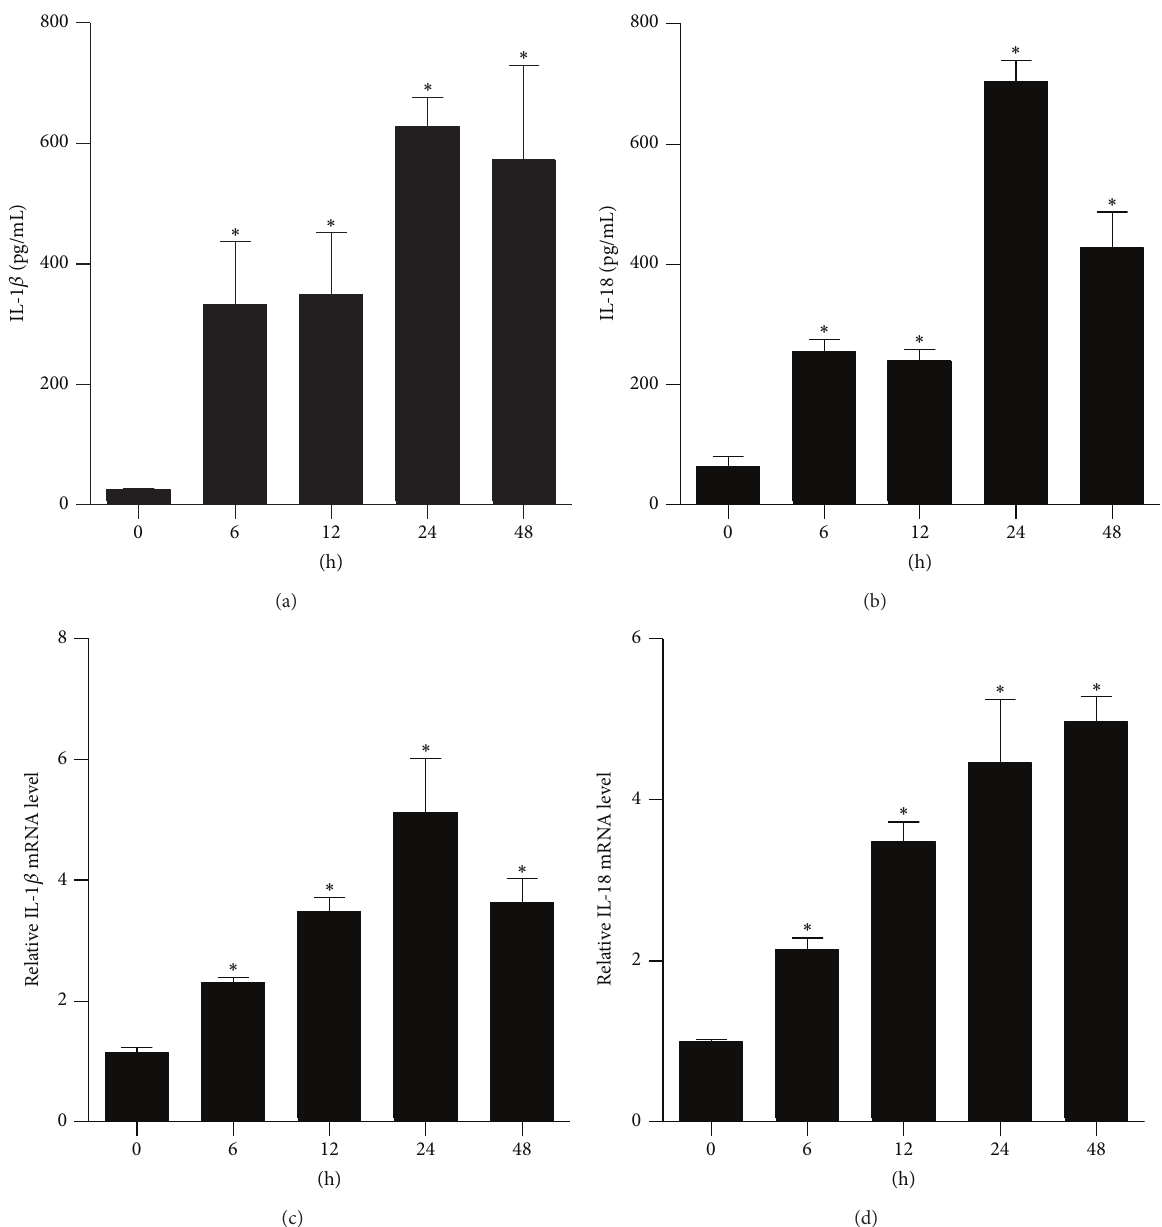
Figure 1: The expression of IL-1 𝛽 and IL-18 in serum and lung tissue from severely burned rats over time. Rats were subjected to burn injury. IL-1 𝛽 (a) and IL-18 (b) in serum were determined using ELISA. The mRNA levels of IL-1 𝛽 (c) and IL-18 (d) in rat lungs were analyzed by real-time PCR and normalized against GAPDH mRNA level. The values presented are mean ± SEM ( 𝑛 = 6 per group). ∗ 𝑃 < 0.05 , compared to the value at 0